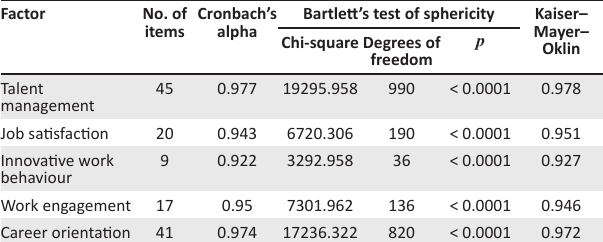
TABLE 1: Reliability , validity and sampling adequacy for talent management, job satisfaction, innovative behaviour, work engagement and career orientation . Factor